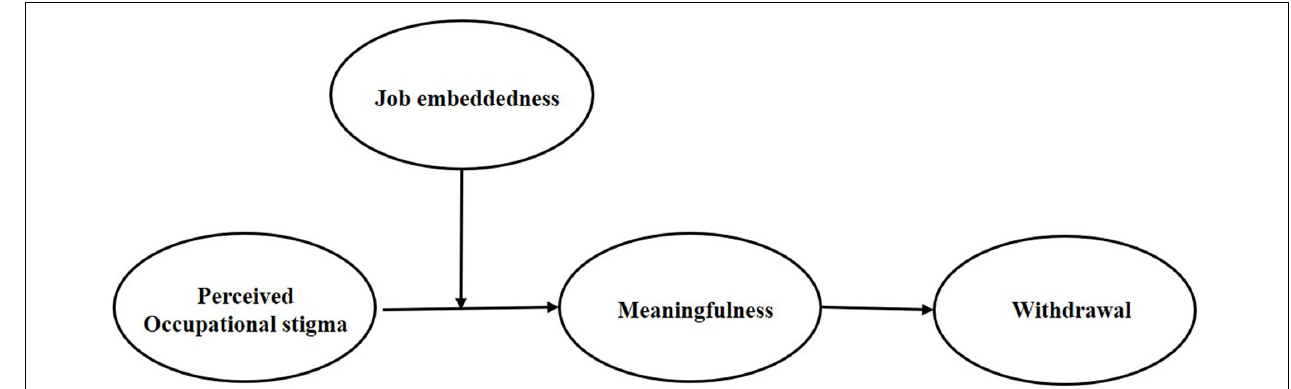
FIGURE 1 | Theoretical model of the current